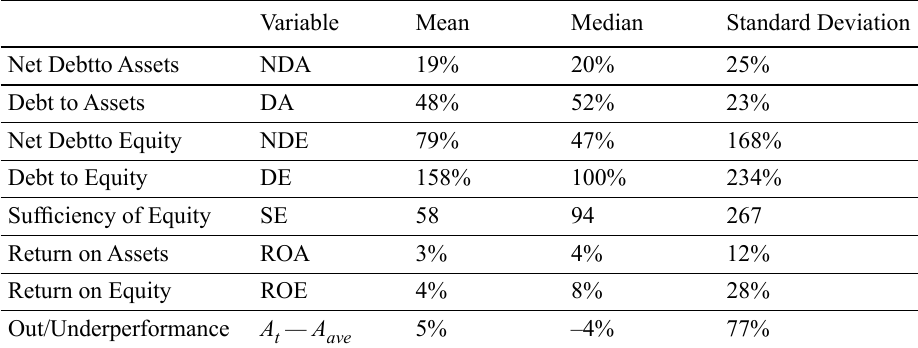
Table 1. Statistical Description of the Variables